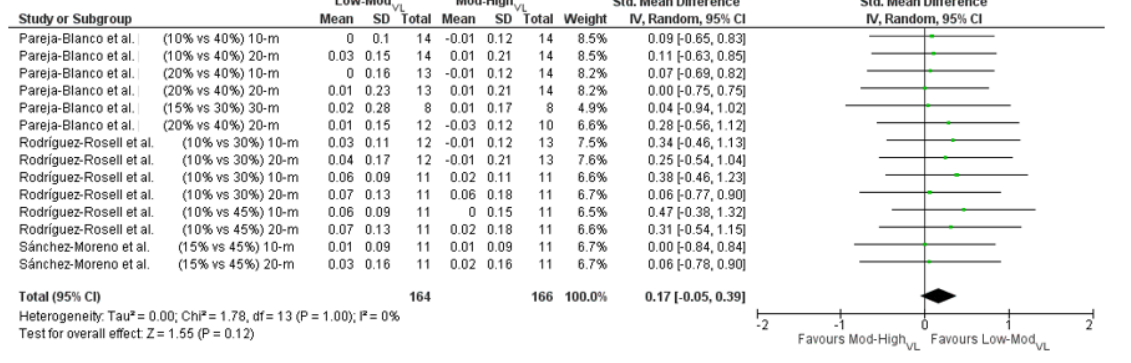
Figure 6. Between-group analysis comparing the effects of Low-Mod VL (≤25% intra -set VL) and Mod-High VL (>25% intra- set VL) to promote changes in sprint capacity. Green squares: ES for each individual comparison; Black diamond: pooled ESs. Sánchez-Moreno et al. [31]; Pareja-Blanco et al. [35,37,38]; Rodríguez-Rosell et al. [34,40].